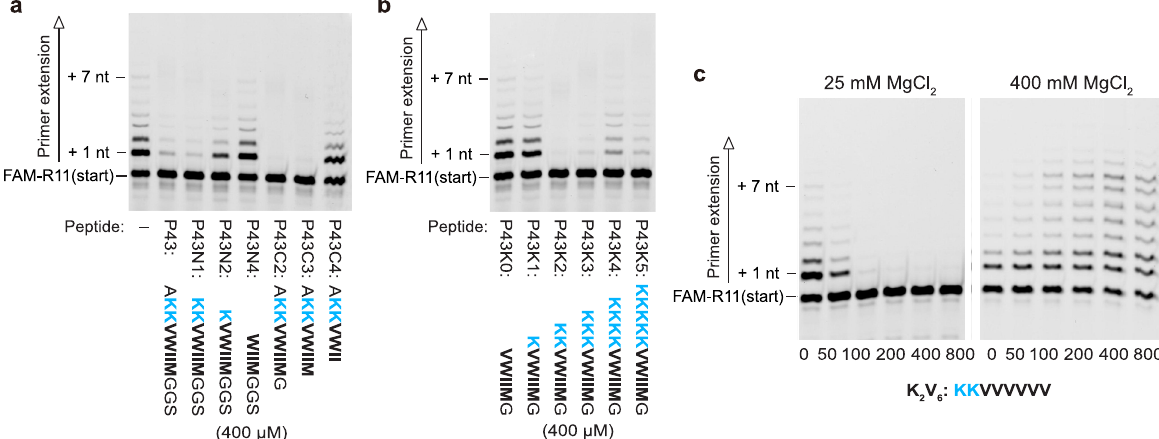
Fig. 3 Inhibition of the RPR activity by P43 variants. Primer extension by RPR Z LT at 25 mM MgCl 2 was performed in 50 mM Tris • HCl (pH 8.3) buffer containing 25 mM MgCl 2 , 8% PEG 6000, 0.4% ( a , b ) or 0.8% ( c ) DMSO and 500 µ M of each NTP. The reactions were incubated at 17 °C for 7